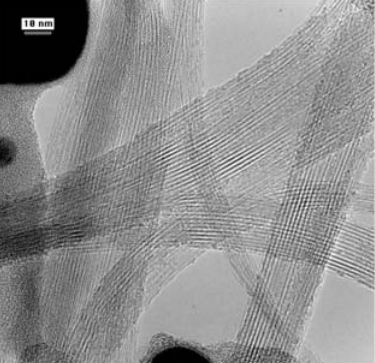
Figure 5. TEM of SWCNTs discovered by Iijima in 1993. Adapted from reference [15], with permission from Nature. Bethume, D.S.; Klang, C.H.; de Vries, M.S.; Gorman, G.; Savoy, R.; Vazquez, J.; Beyers, R. Cobalt-catalysed growth of carbon nanotubes with